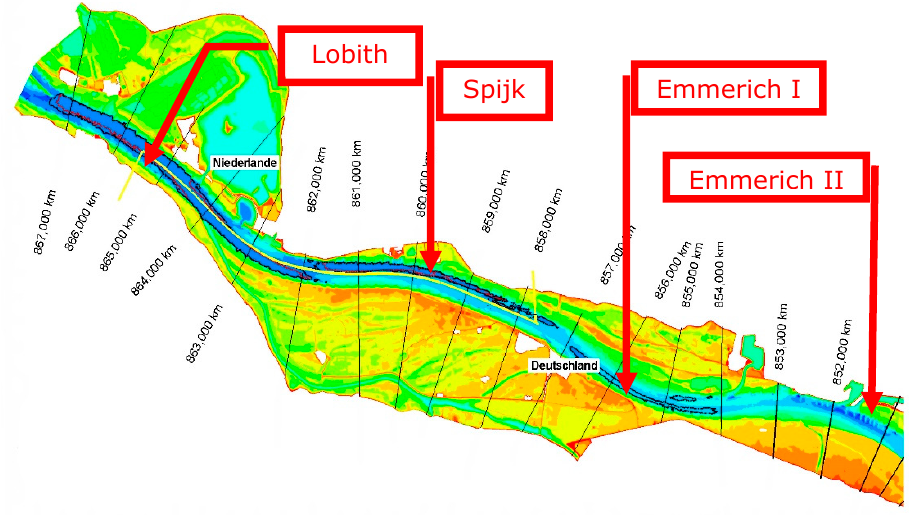
Figure 26. River bed stabilization and larger navigation channel by structural measures and sediment supply. Lobith: sediment supply and fixed layer. Spijk, Emmerich I and II: fixed layers (copyright [25]).